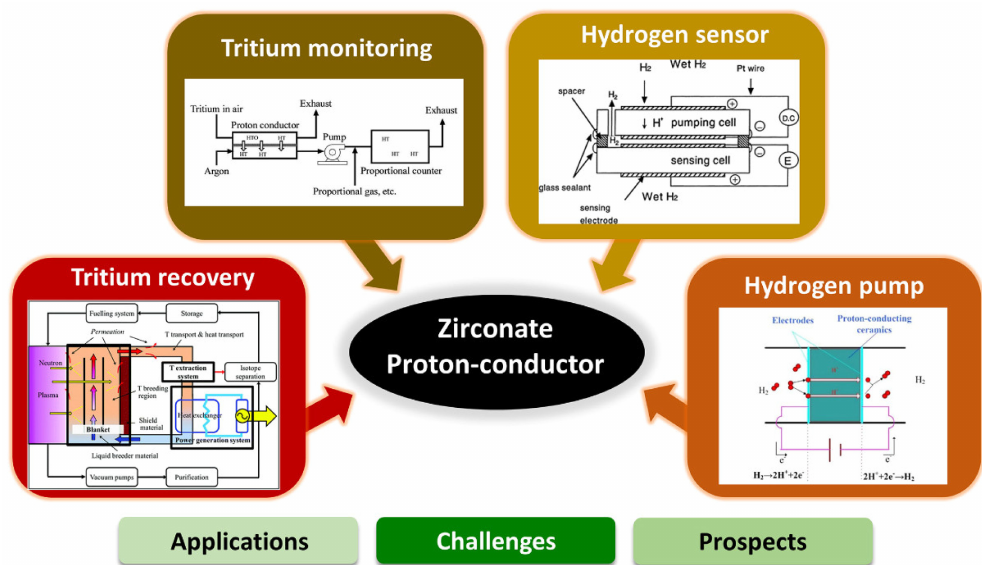
Figure 1. An outline of the main points of this review shown